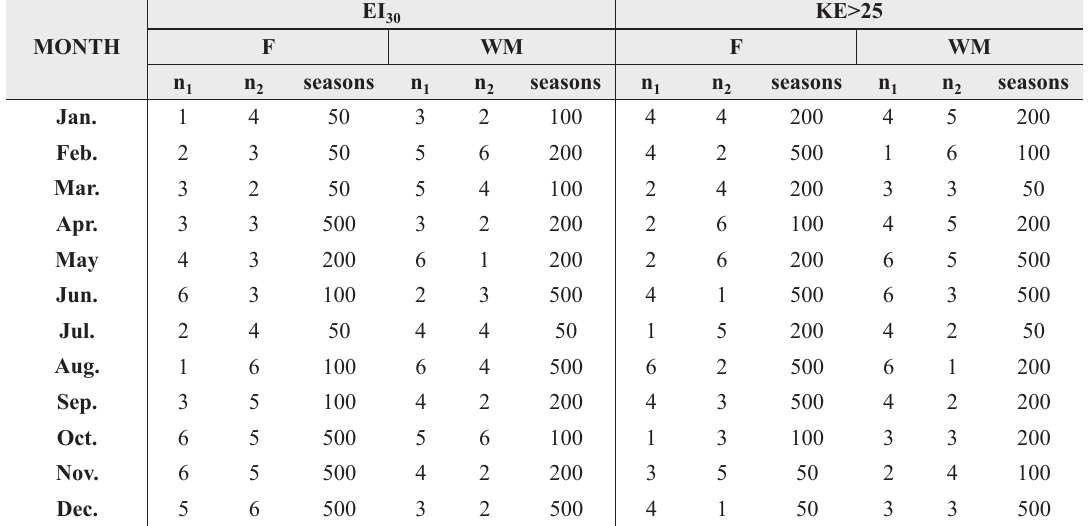
Number of neurons on intermediate layers and training seasons of the ANN developed to spatial interpolation of monthly EI e KE>25 erosivity indices (computed considering WS and WM equations) at Espírito 30